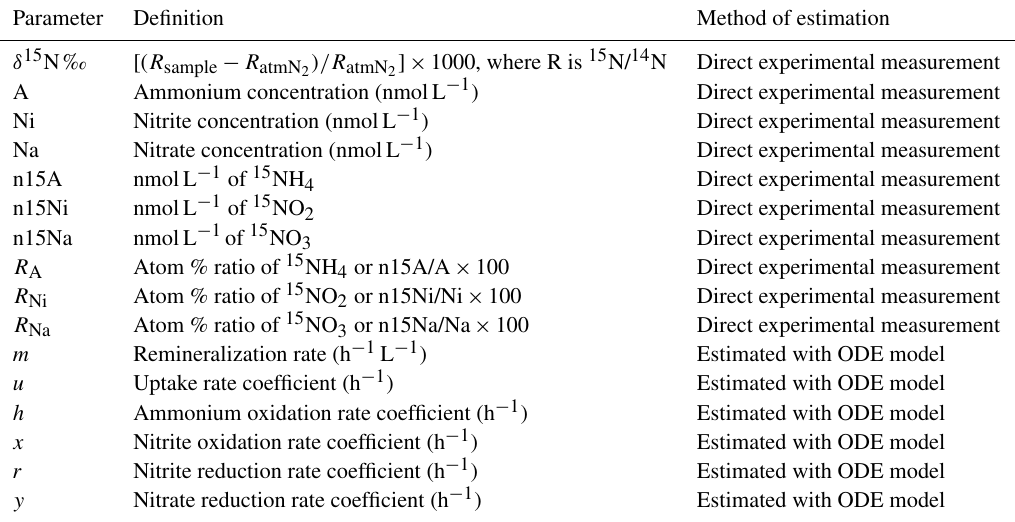
Table 1. A list of observed and modeled parameters used in this study. Parameter Definition Method of estimation